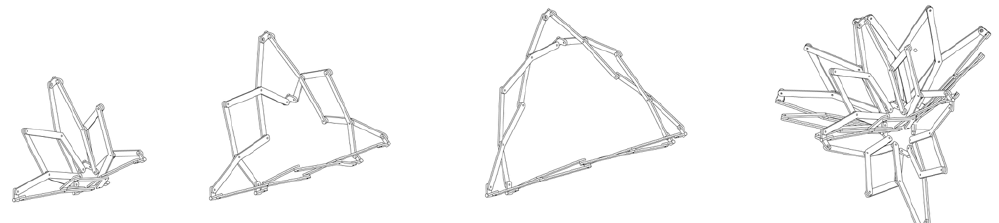
Figure 4. Detailed design modeling of polar array assemblies based on the expansion and contraction principles of a Hobermann sphere.